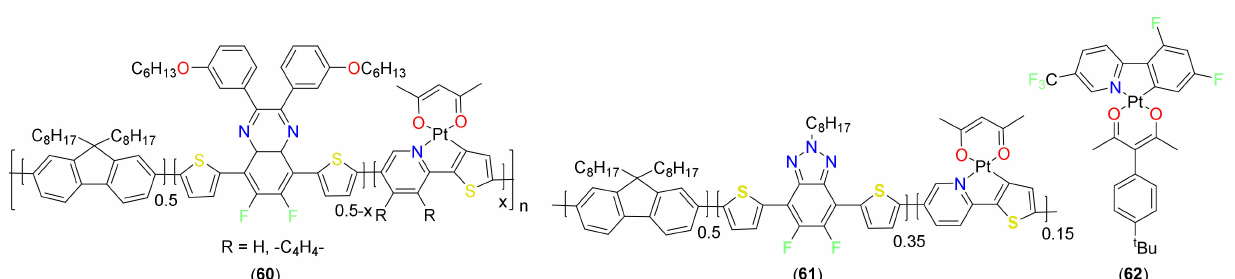
Figure 16. Cyclometalated Pt(II) complex-based photocatalysts and others.